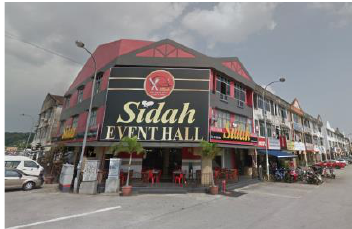
Figure 7: Image for Taman Perindustrian Saujana Indah, (Source: Google Maps)